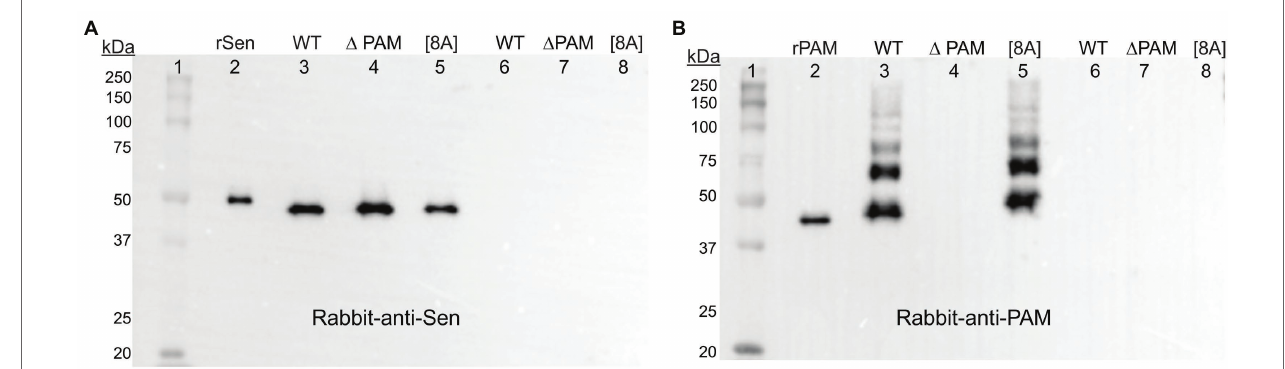
FIGURE 8 | Presence of biotinylated AP53 proteins in the CWs of mutant strains of AP53 GAS. The isogenic AP53 strains were incubated with sulfo-NHS-SS-biotin prior to PlyC treatment and excess biotin washed from the cells. PlyC was then added and the CW digests containing biotin-labeled proteins were isolated by streptavidin- Sepharose columns. Biotinylated proteins were eluted with mercaptoethanol. The samples were analyzed by: (A) Western blotting with rabbit anti-Sen. Lane 1, molecular weight markers; Lane 2, rSen; Lane 3, WT-AP53 (WT); Lane 4, AP53/ ∆ pam ( ∆ PAM); Lane 5, AP53/ pam[8A] [8A] cells. Lanes 6–8 are cells not treated with sulfo-SS-NHS- biotin and used as negative controls for samples in Lanes 3–5. (B) As in (A) except that rabbit-anti-PAM was used and Lane 1 is rPAM in place of